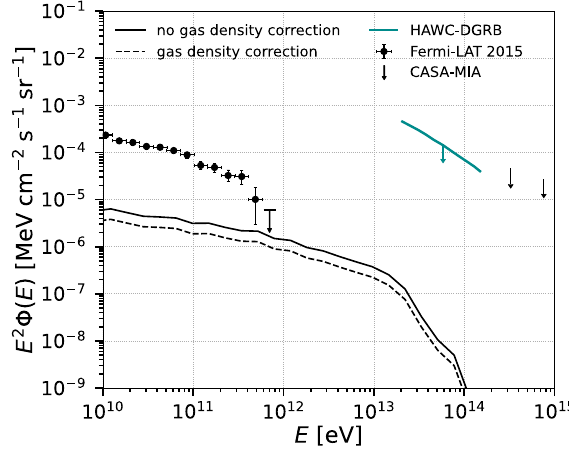
Fig. 5 | Integrated gamma-ray fl ux from the entire population of clusters. The pinkshadedregionrepresentstheintegratedgamma-ray fl uxobtainedinthiswork for E max =10 16 (cid:1) 10 17 eV and spectral index α =1.5 − 2.5, as well as all source evo- lutions considered (AGN, SFR, and no evolution). This is compared with the total gamma-ray fl ux from clusters obtained in previous works 6,41 , and also with the DGRB observations from Fermi-LAT (error bars correspond to the total uncer- tainties, statisticaland systematic) 66 , aswellasthe upper limits obtained by HAWC (95% con fi dence level) 31 and CASA-MIA (90% con fi dence level) 32